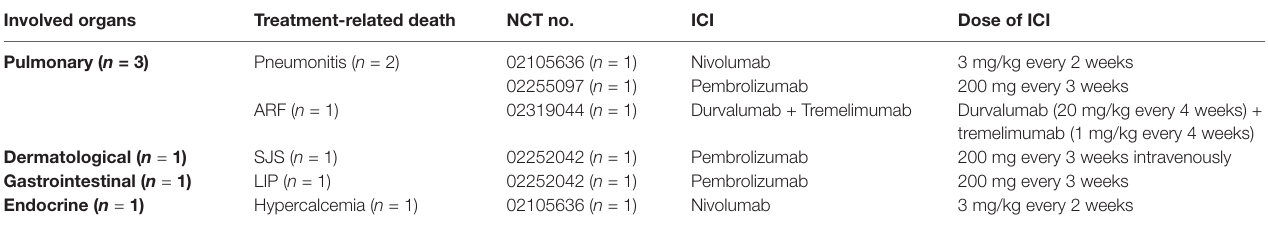
TABLE 4 | Baseline characteristics of death cases and involved clinical trials. Involved organs Treatment-related death